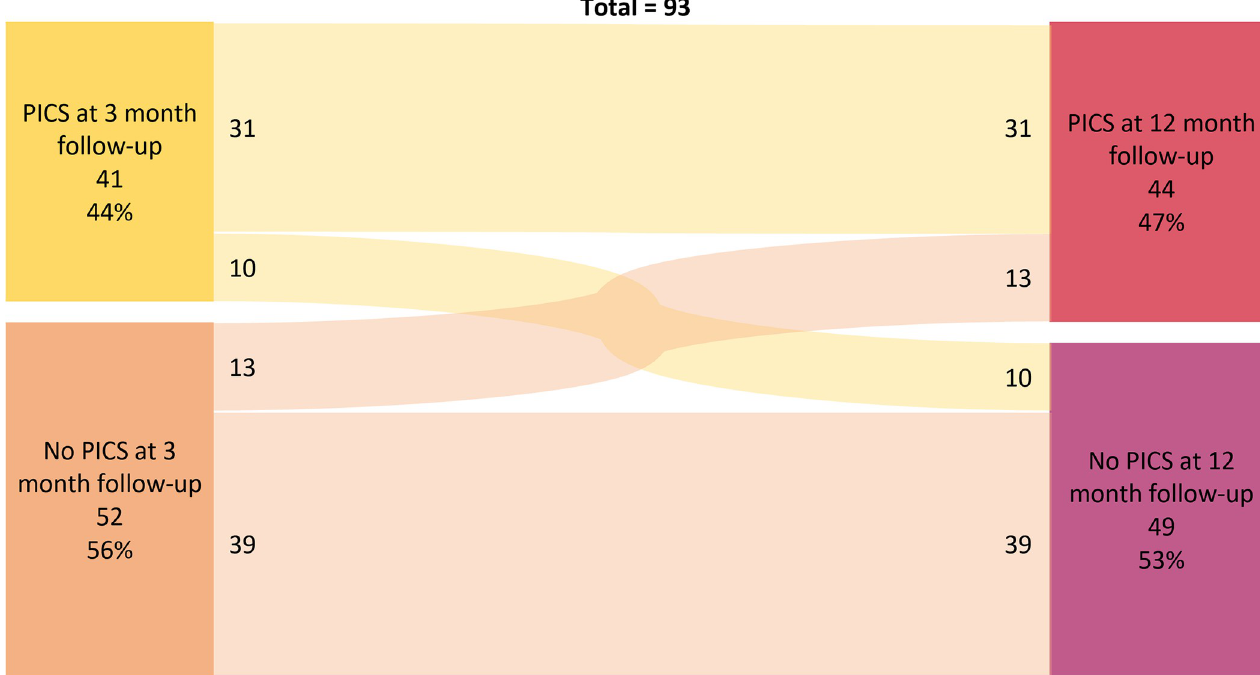
Fig 3. Sankey diagram of occurrence of PICS or no PICS at 3 and 12